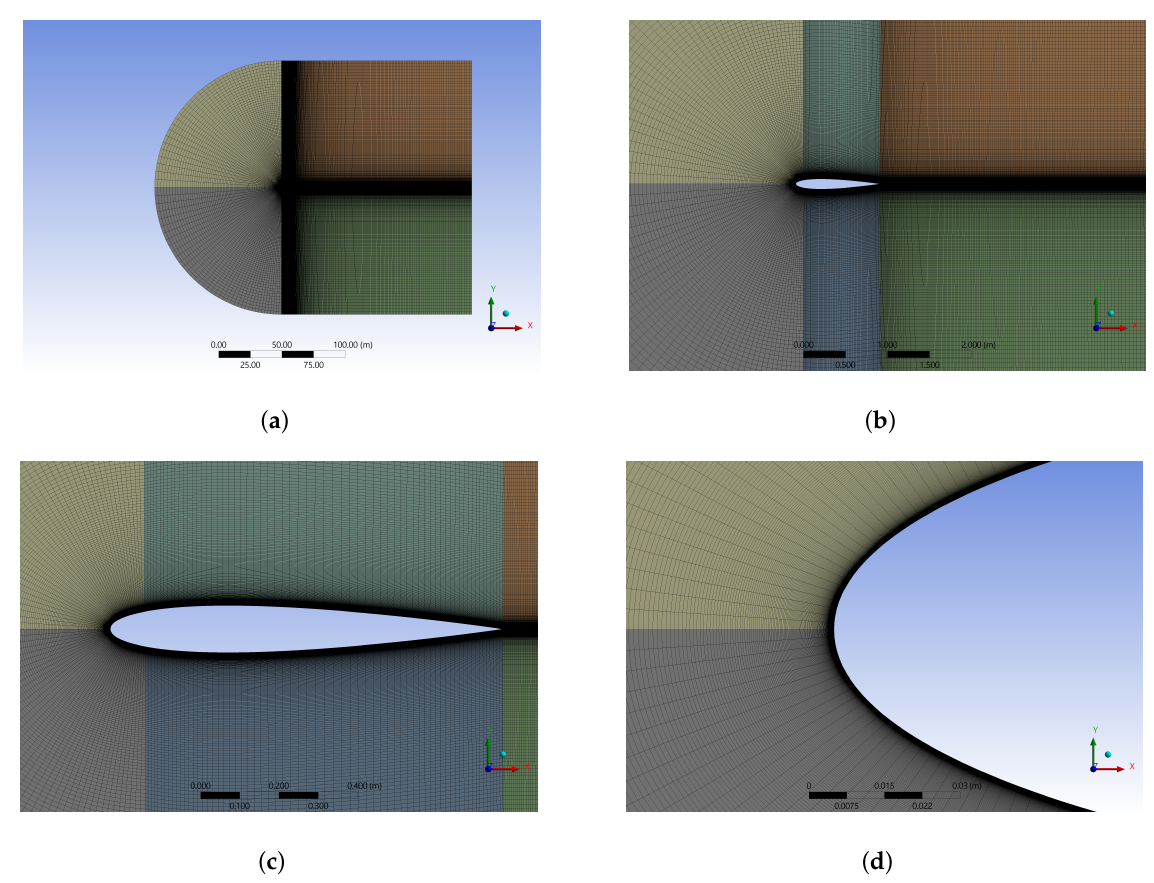
Figure A2. 2-D airfoil CFD simulation setup: ( a ) the solution domain includes a C-shape of the radius of 100 m upstream and a rectangle of the length of 150 m and width of 200 m downstream of the airfoil, ( b ) wake region behind the airfoil, which has been refined to capture vortex shedding from the airfoil, ( c ) mesh around the airfoil section (NACA 0012 airfoil, chord: 1.0 m, Max. thickness: 0.12 m), and ( d ) a close-up view showing the boundary layer mesh close to the leading edge (No. of inflation layers around the airfoil: 22, the growth ratio: